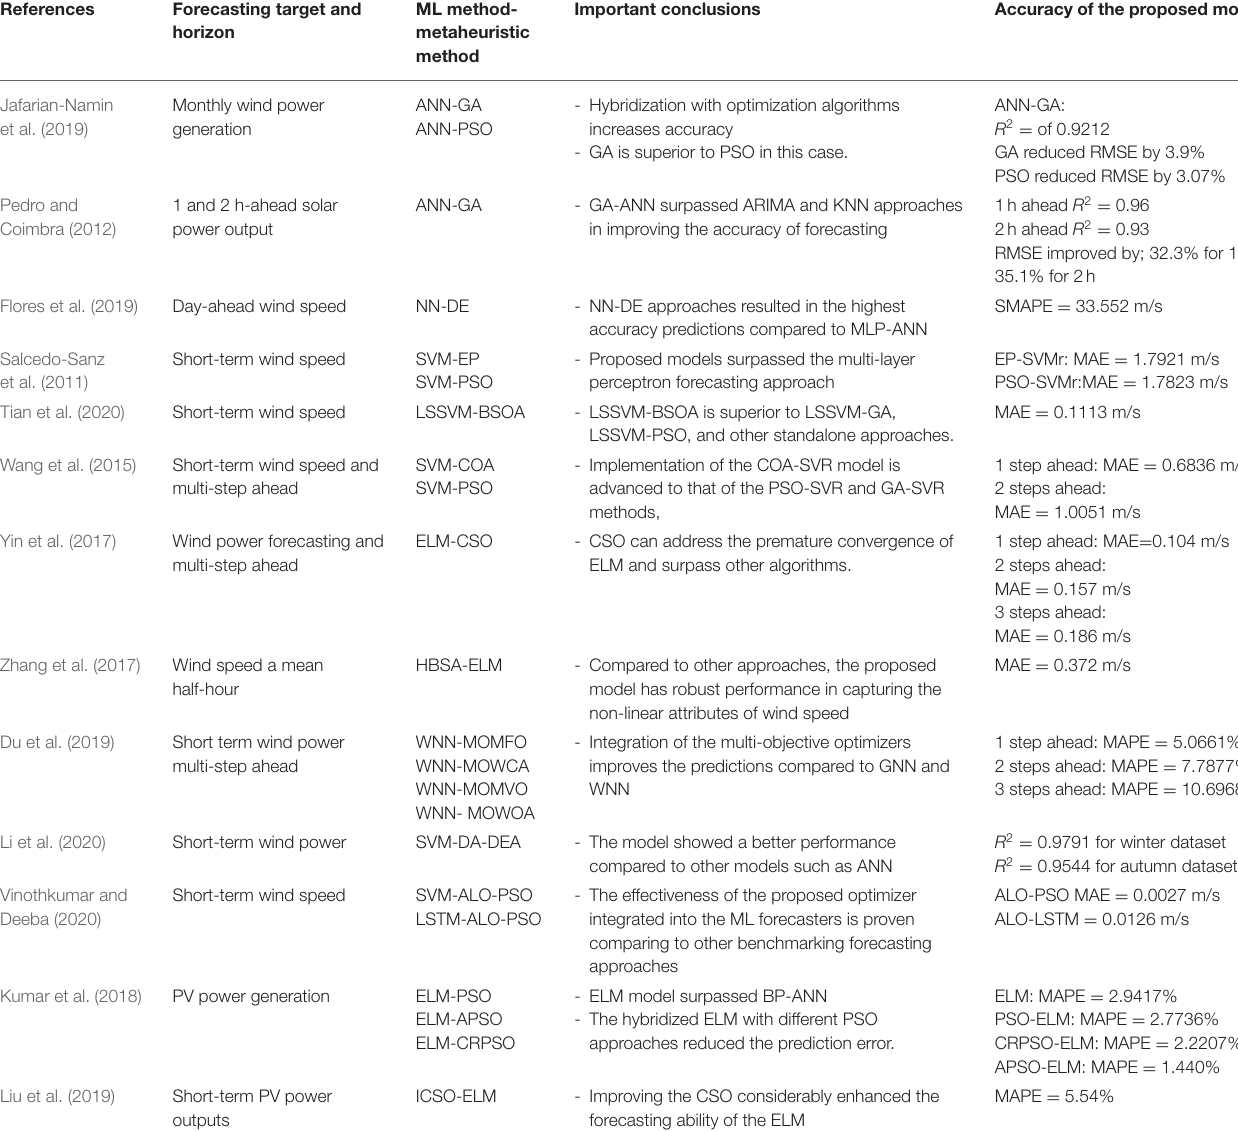
TABLE 4 | Summary of machine learning- (ML-) metaheuristic